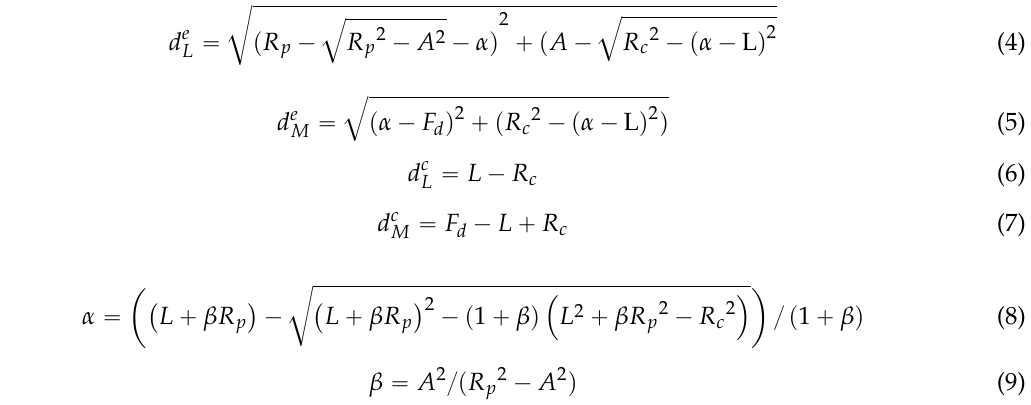
Figure 1. Conventional lens configuration and design parameters: ( a ) concave and ( b ) convex lenses.